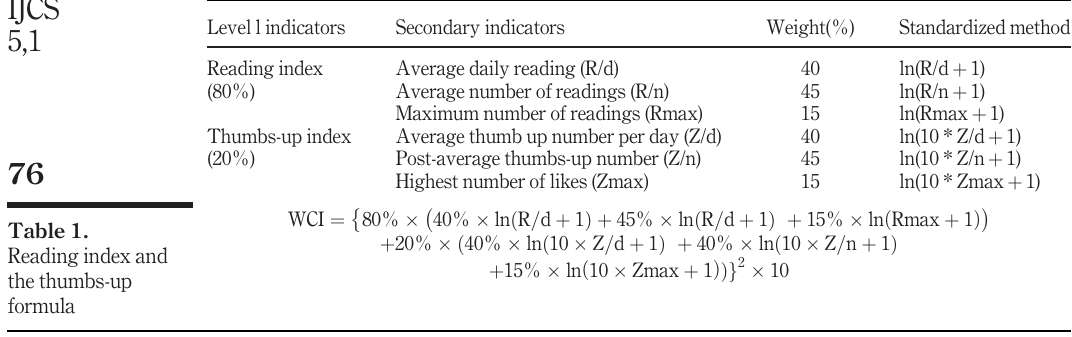
Table 1. Reading index and the thumbs-up